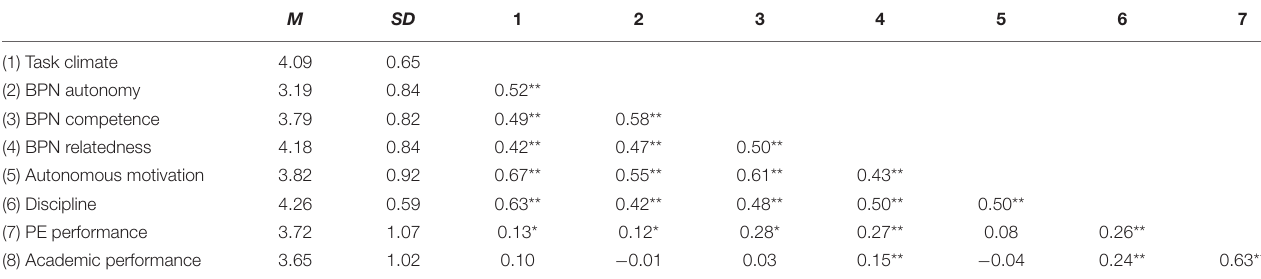
TABLE 1 | Descriptive analyses, values, and correlations.